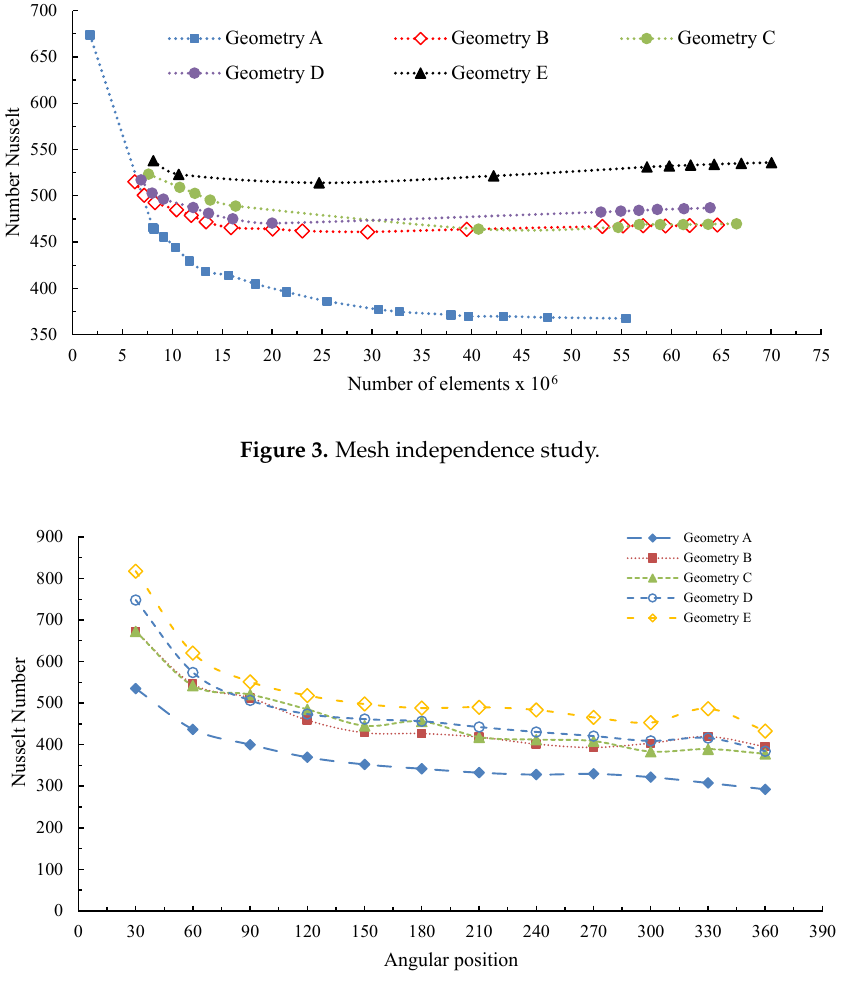
Figure 4. Nusselt number for several positions in the first turn of heat